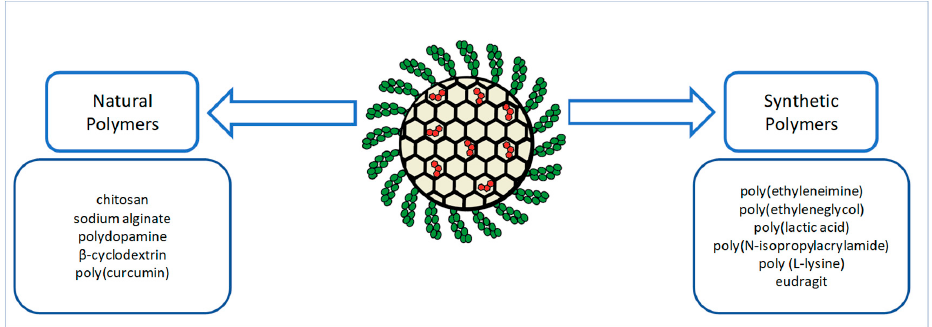
Figure 2. Polymers of natural and synthetic origin that have been used as coating agent for MSN for providing control over drug release.